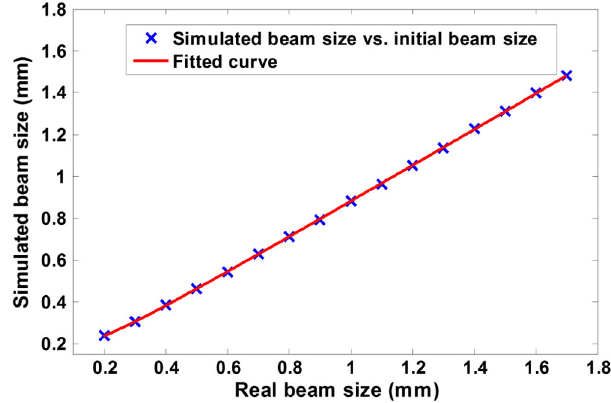
FIG. 11. Image broadening by thermal spread and radial component of the external field, with different initial or real beam sizes. The curve is fitted according to Eq. (1), with R 2 ¼ 1 .